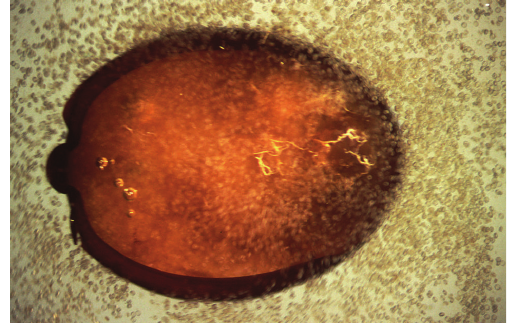
Figure 11: Eggs of Myrmeconema neotropicum released from the gaster of an infected Cephalotes atratus worker in Peru.